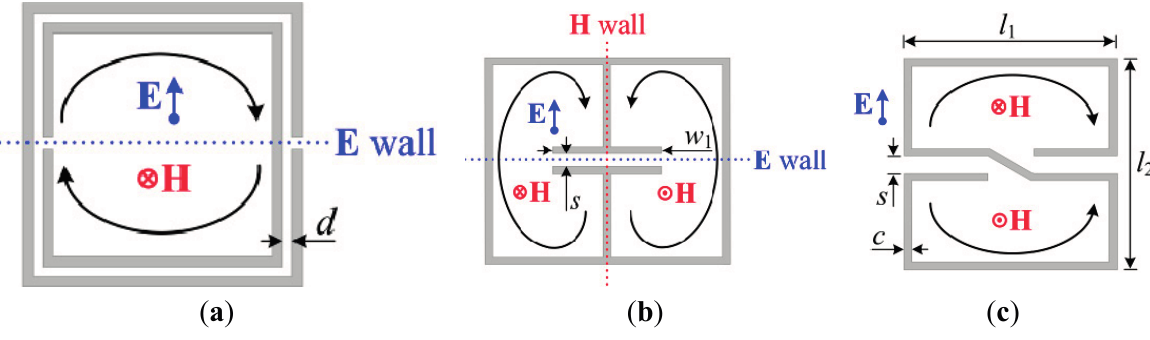
Figure 1. Typical topology of an SRR ( a ), an ELC resonator ( b ), and an S-SRR ( c ). The fundamental resonance is characterized by the orientation of external polarization fields, induced boundary conditions (electric/magnetic walls) at the symmetry planes, and a sketch of the